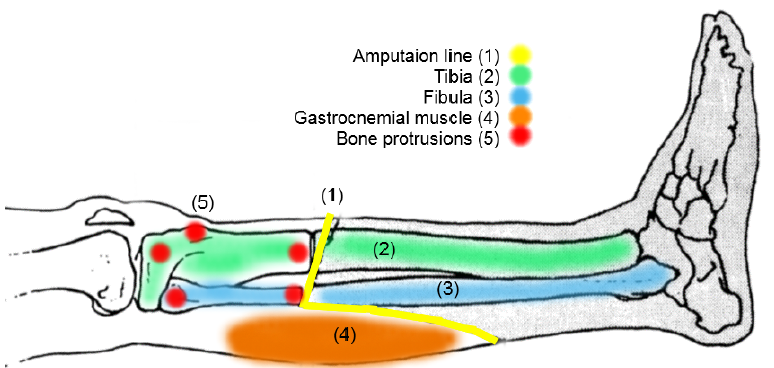
Figure 3. Amputation line for the transtibial amputee showing residual anatomy points of pressure over soft tissue. The bone protrusions include tibial and fibula epicondyle, head of the tibia, and distal amputation line for the tibia and fibula noted in red points (based on Reference